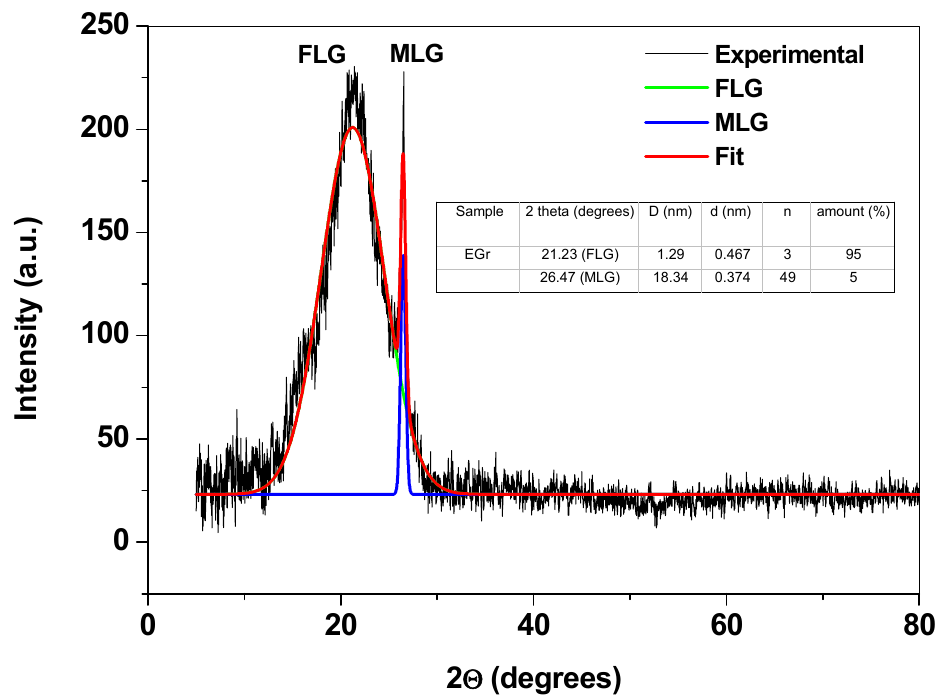
Figure 2. The XRD pattern of EGr sample dispersed in DMF and deposited onto a quartz substrate, showing the two peaks attributed to FLG and MLG; inset: the structural parameters determined from the XRD pattern: the mean size of graphene crystallite (D), the interlayer spacing (d), the average number of layers in graphene crystallites (n), and the amount (%) of FLG and MLG present within the sample.